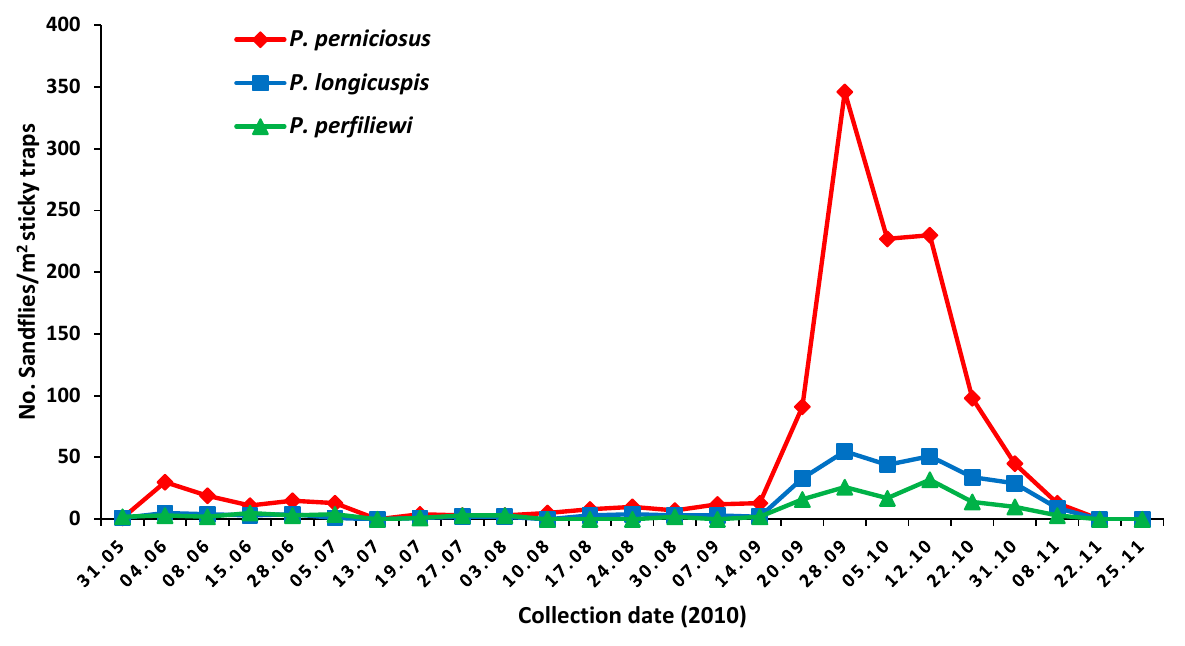
Figure 1. Phenology of sandflies collected in the site of Utique, 2010. A total of 57 pools were formed from collected sandflies in 2009 and used for virus detection. One pool (T101), corresponding to 30 P. perniciosus females trapped in October 2009, was found to contain PUNV RNA (Table 2). Thus, the IR of sandflies with PUNV was 0.11%. Table 2. Composition sandflies collected from Utique during 2009 according to date of collection, species, sex, and number (%) of specimens investigated for the presence of phlebovirus. Date of Collection